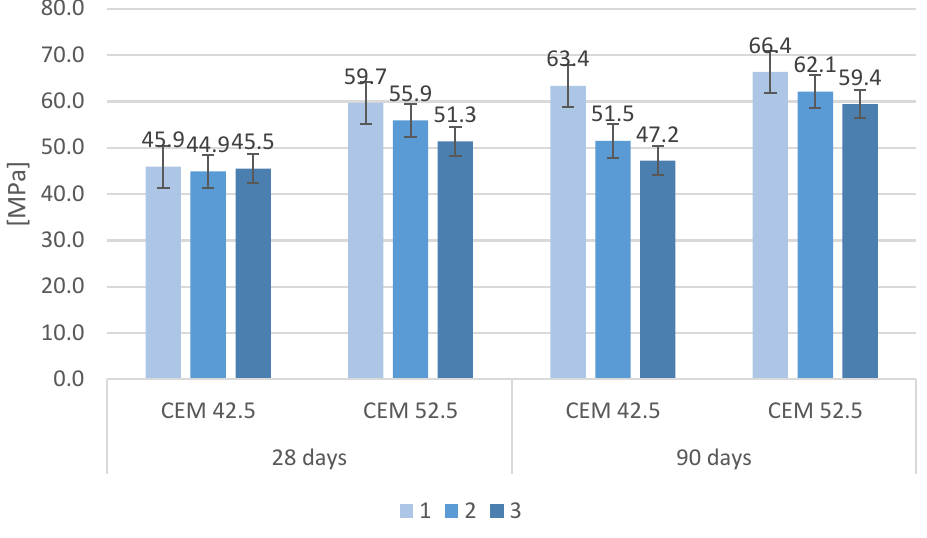
Figure 7. Compressive strength of cement mortars in relation to cement grade.